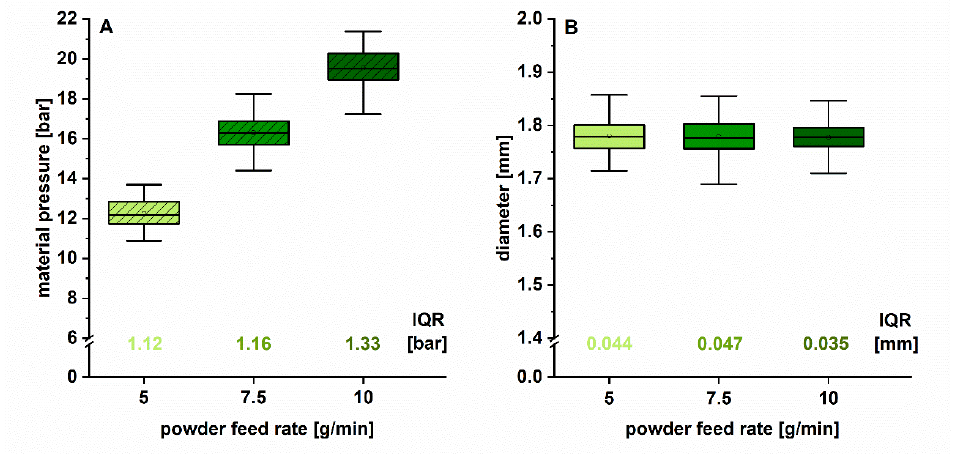
Figure 5. Boxplot of inline measured material pressure at the die ( A ) and filament diameter ( B ) (1 Hz, n > 294) for different applied PFR. The respective IQRs (box width) are indicated.